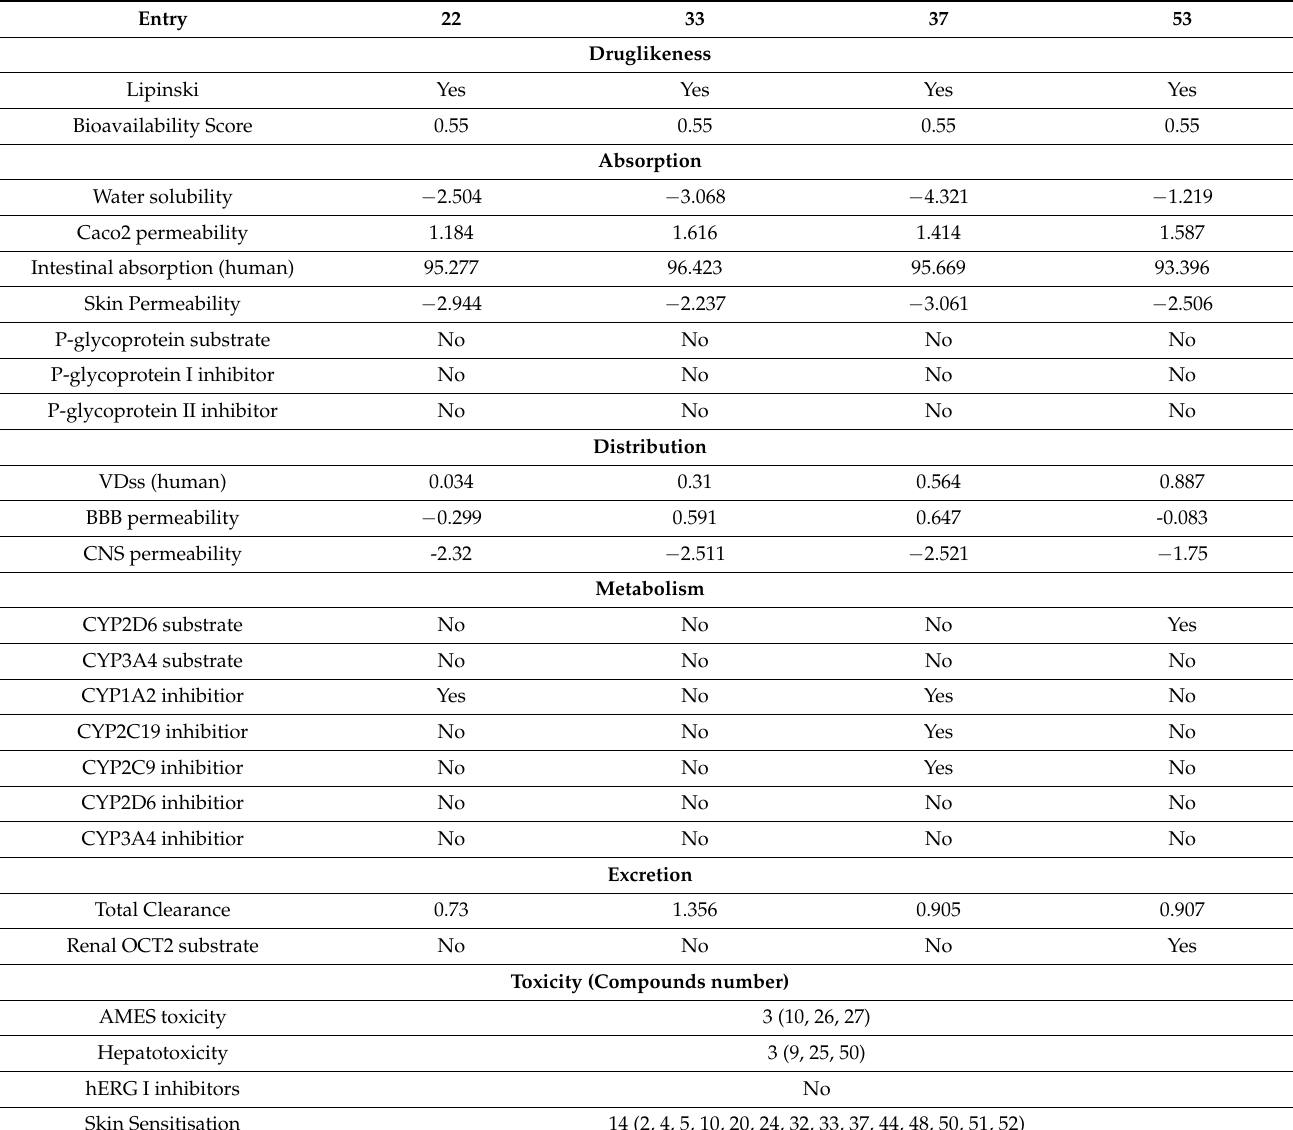
Table 3. Absorption, distribution, metabolism, excretionandtoxicity(ADMET)propertiesofsometopidentifiedphytocompounds.